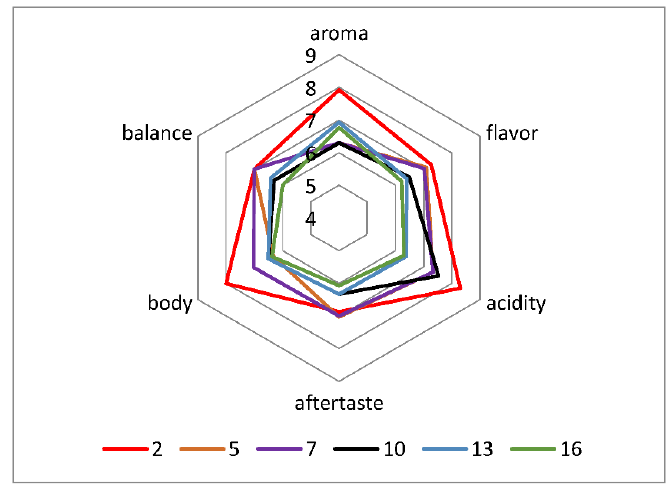
Figure 2. Sensory analysis of extraction under reduced pressure (variation of vacuum cycles).